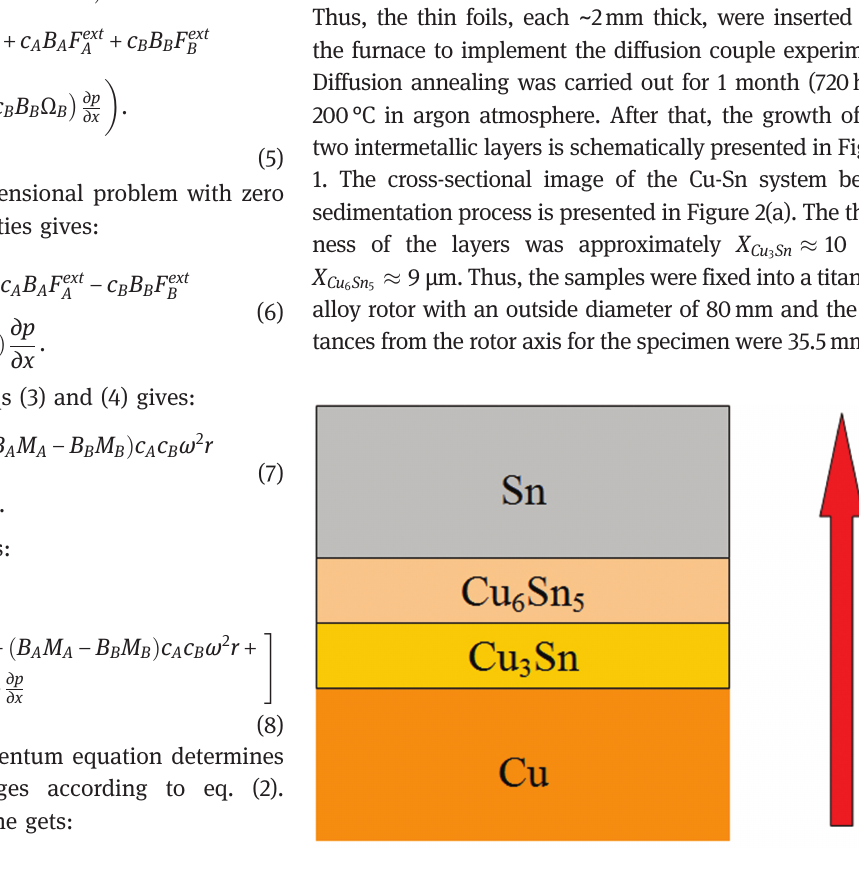
Figure 1: Schematic view of the sedimentation process in the inter- metallic Cu-Sn